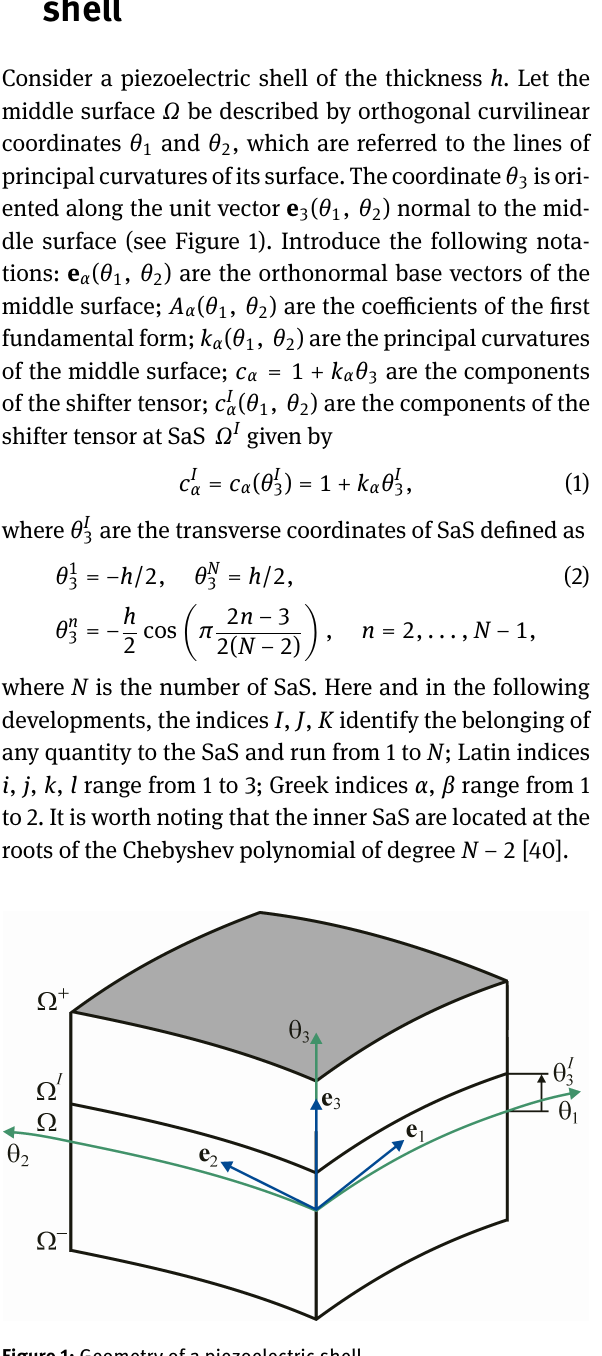
Figure 1: Geometry of a piezoelectric